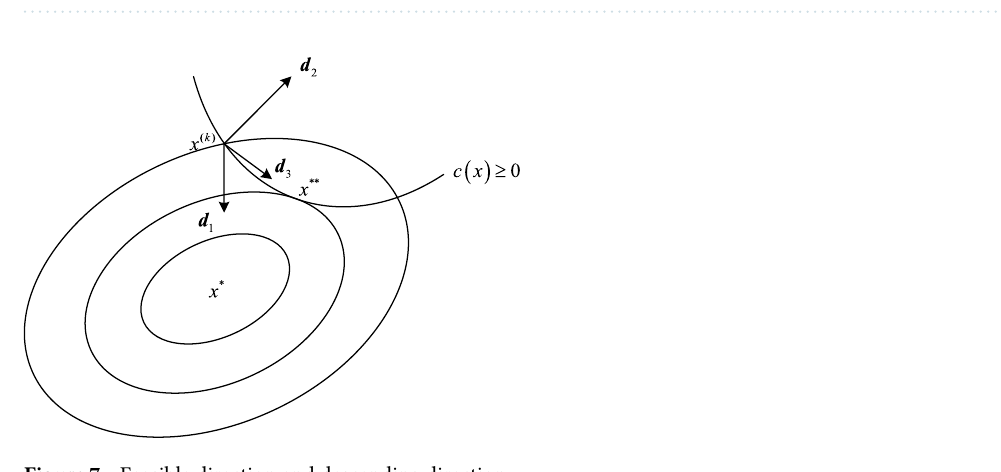
Figure 6. Flow chart of the optimization problem.